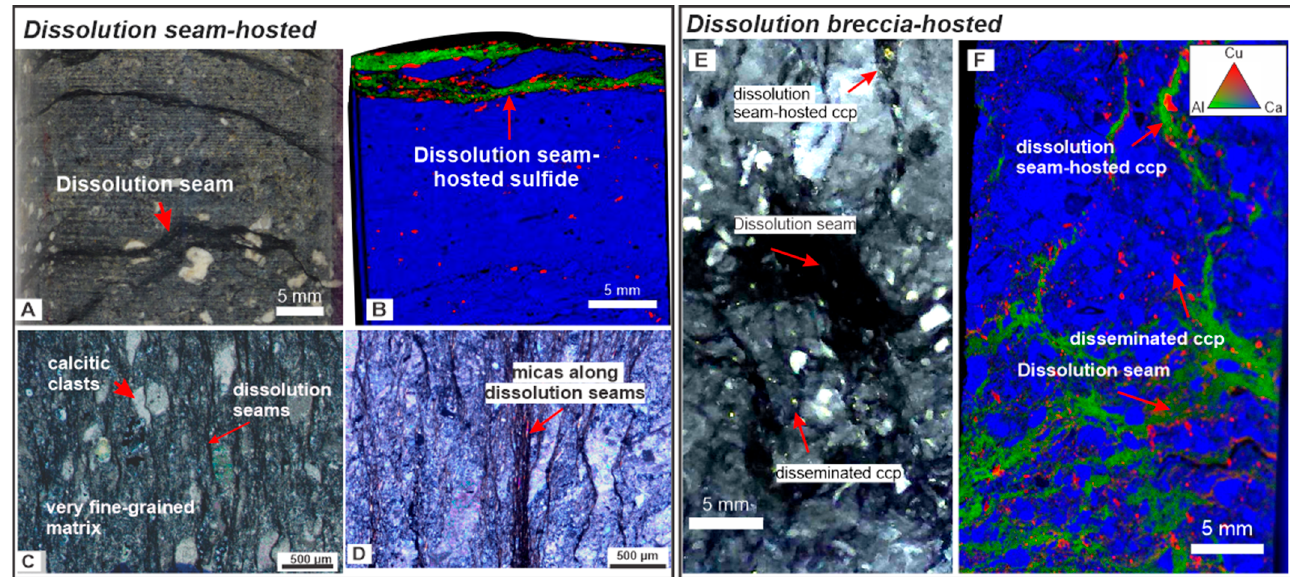
Figure 7. ( A ) Hand sample images showing dissolution seams. Note that the seams are cutting the calcite clasts. ( B ) Semi-quantitative chemical maps obtained by micro-X-ray fluorescence (µFRX). The figures show dissolution seam-hosted sulfides. ( C ) Calcite clasts cut by dissolution seams in a very fine-grained matrix. ( D ) Very-fine grained matrix with mica along bedding-parallel dissolution seams. ( E ) Hand sample images and ( F ) Semi-quantitative chemical maps by µFRX showing dissolution breccia hosted sulfide and sulfosalts.